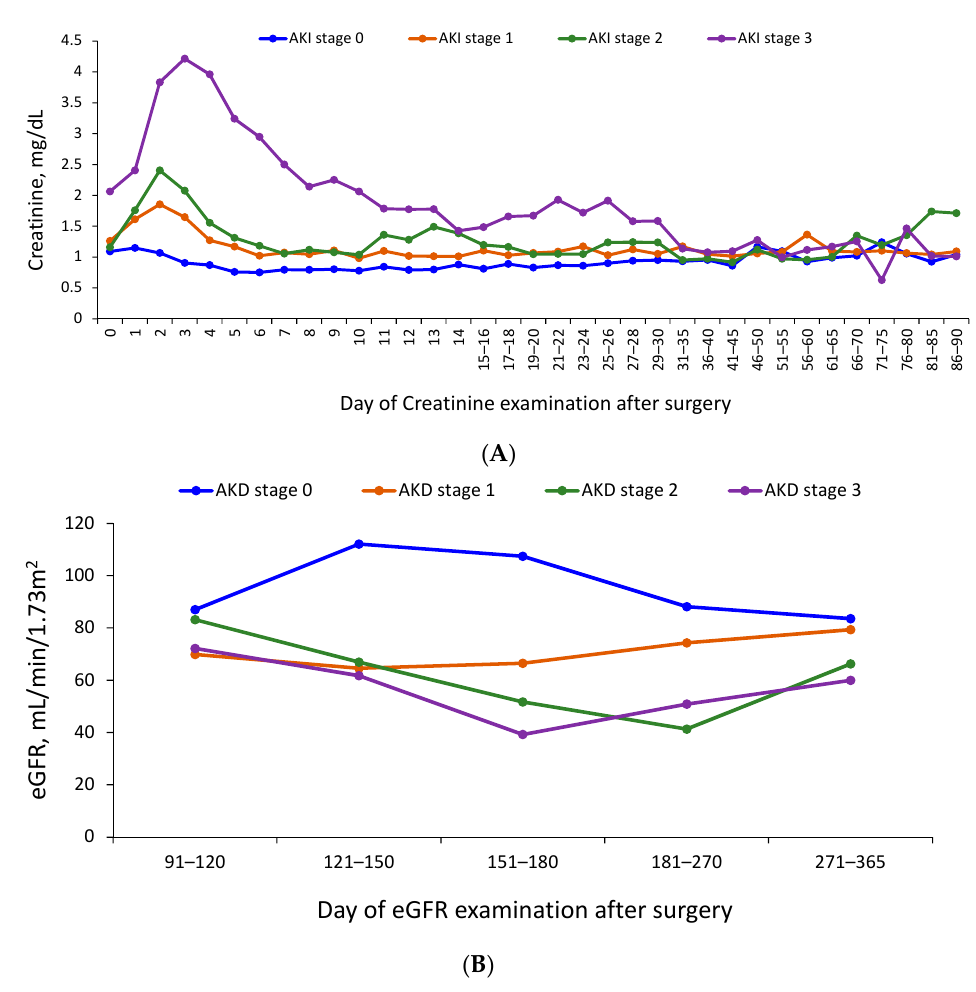
Figure 2. Kidney function trajectory after acute kidney injury and acute kidney disease. ( A ) Trend of creatinine levels after operation according to AKI stage. AKI, acute kidney injury. ( B ) Trend of eGFR after operation according to AKD stage. Creatinine or eGFR data after dialysis initiation were not included in the figure. AKD, acute kidney disease; eGFR, estimated glomerular filtration rate.